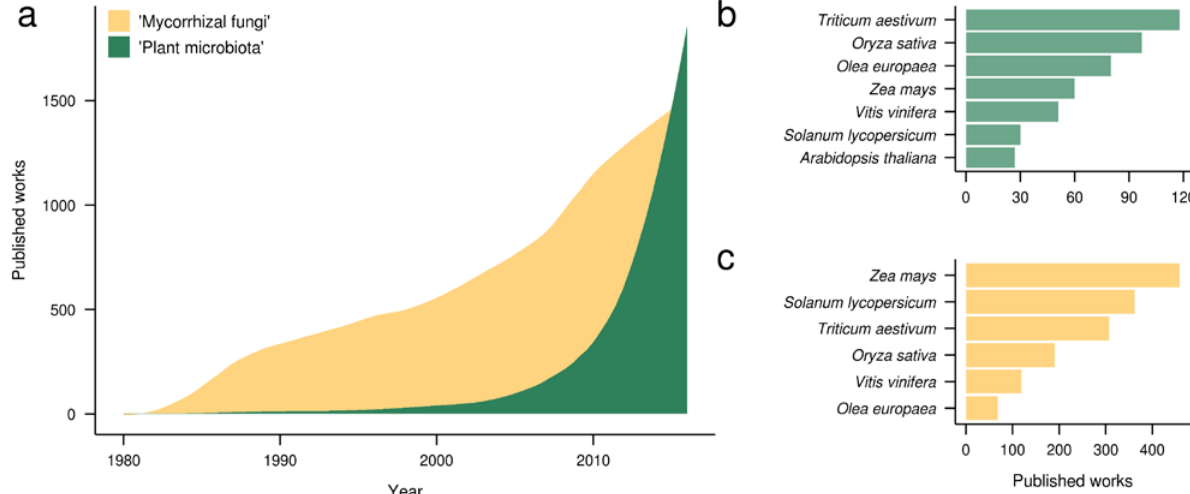
Figure 4. Analysis of literature (last four decades), by ‘Plant microbiota’ and ‘Mycorrhizal fungi’ keywords. a, Numbers of published studies on each topic (in green and orange respectively). b-c, Analysis of occurrence in titles by main model and crop species in the Mediterranean region is reported for each topic presented in panel a. Literature was searched by using ISI Web of Science database for the period